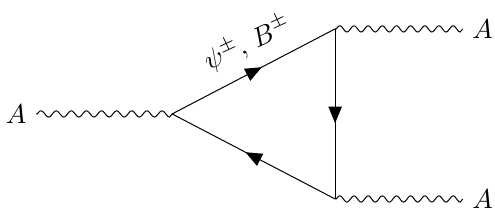
Figure 1 . Triangle diagram with three external gauge (cid:12)elds and (cid:12)elds with parity violating actions running in the loop, generating (cid:12)ve-dimensional CS